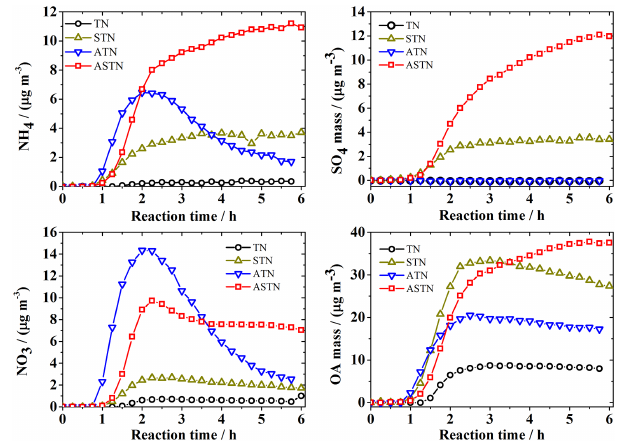
Figure 3. Time variations of the chemical species in the secondary aerosol generated from the photooxidation of toluene / NO x in the presence or absence of NH 3 and SO 2 . Letter codes for experiments indicate the introduced pollutants, i.e. A for ammonia, S for sulfur dioxide, T for toluene, and N for nitrogen dioxide. Experimental details are listed in Table 1.